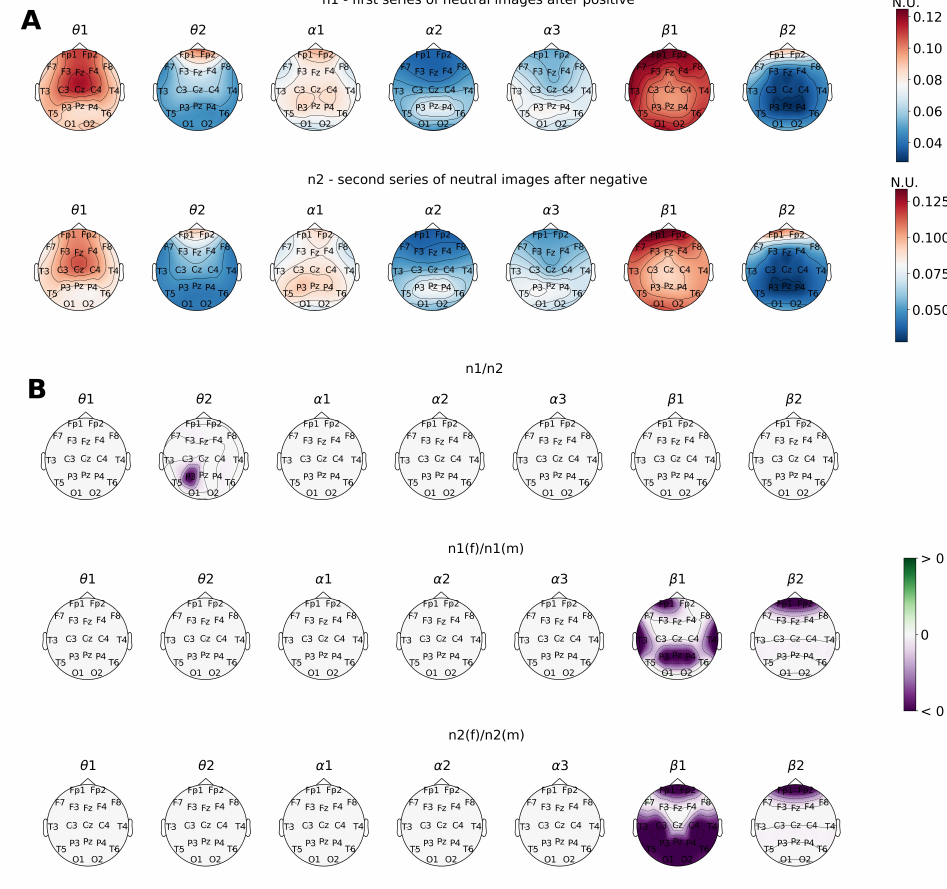
Figure 2. Topographic distribution ( A ) and regions of statistically significant differences ( B ) in PSD values during perception of neutral faces, which were preceded by positive (n1) and negative (n2)